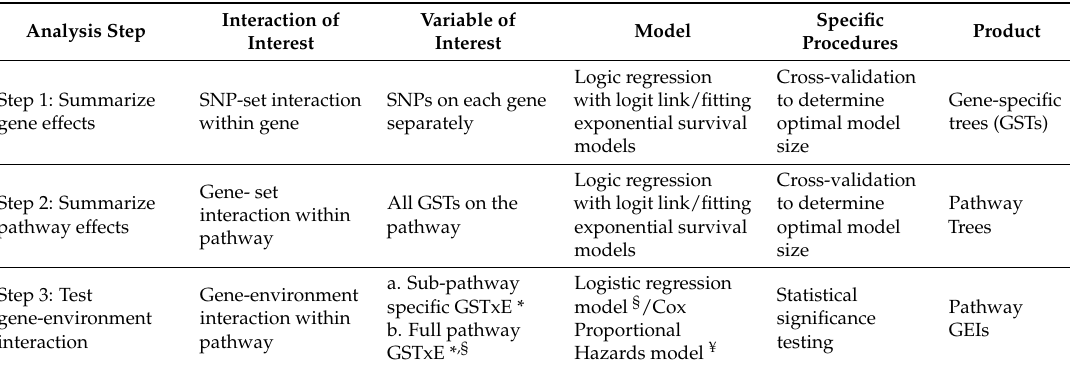
Table 1. Summary of the 3-step candidate pathway gene-environment interaction